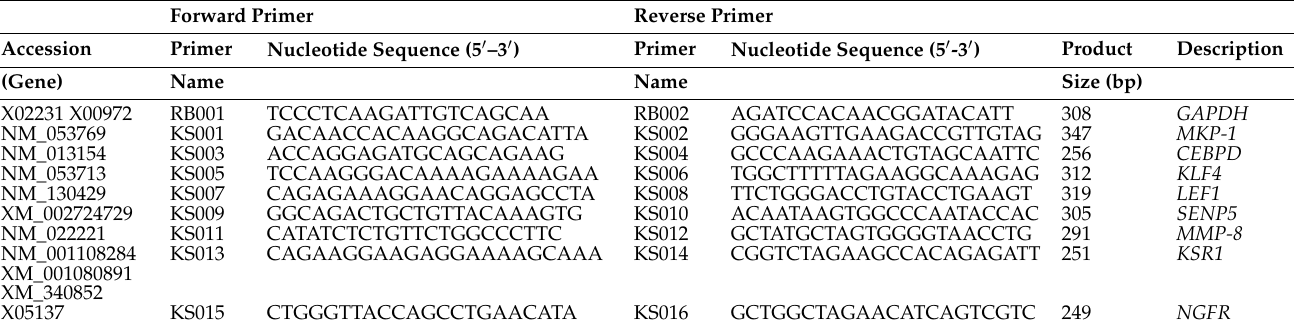
Table 1. Primer combinations used for